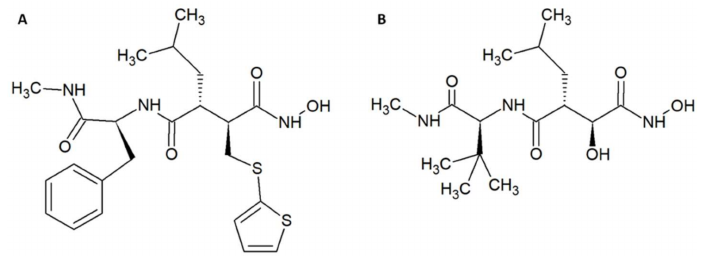
Figure 2. Chemical structures of ( A ) batimastat. ( B )